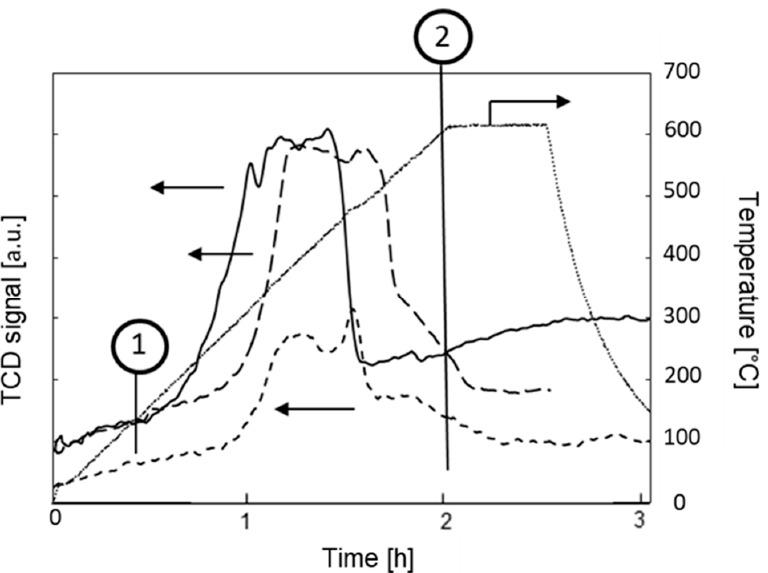
Figure 8 . Temperature Programmed Oxidation (TPO) results of the undoped cobalt catalyst (long dashes: 475 mg; short dashes: 210 mg) and Co3.5La (solid line: 475 mg) and the function of temperature in time (dotted line); line 1 indicates the onset of oxidation of Co3.5La, line 2 indicates the beginning of the isothermal segment.